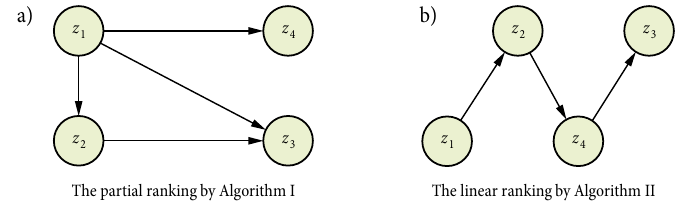
Fig. 1. Decision graph obtained using the IVIF-ELECTRE outranking